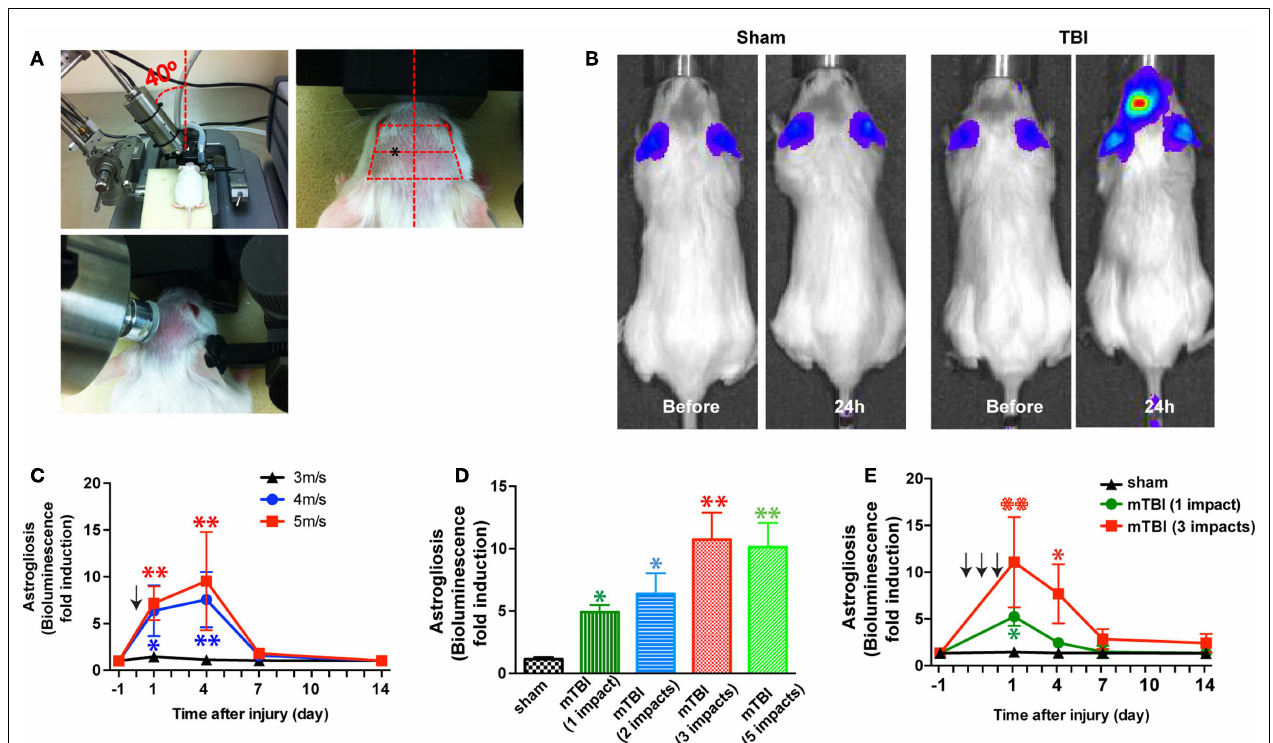
2–3months old, body weight 20.45 ± 2.13g) were randomly assigned to receive different number of impacts.The impact was induced at a speed